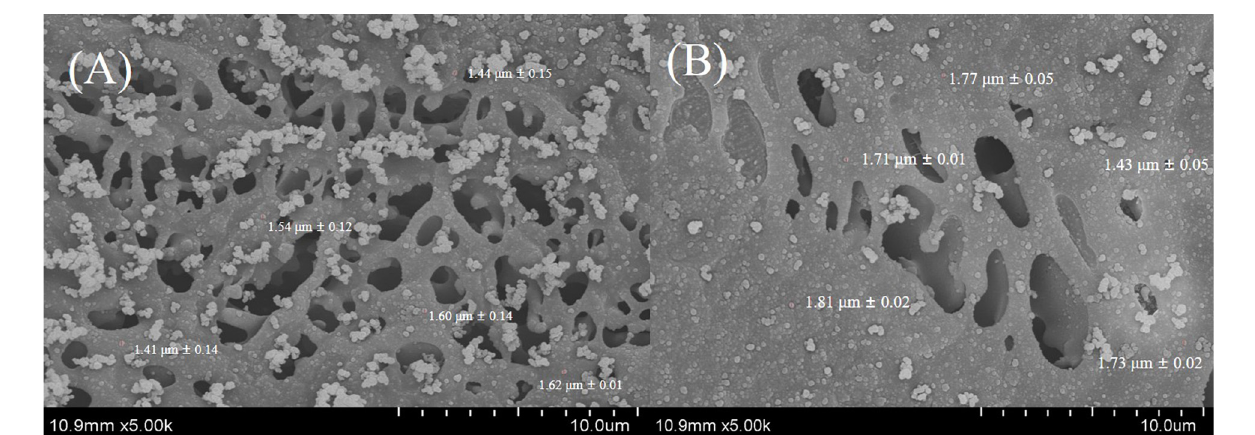
FIGURE 5 | The cryo-SEM micrographs of the Thy-Emulsion (A) and Thy/LA 25% -Emulsion (B) . n = 3.